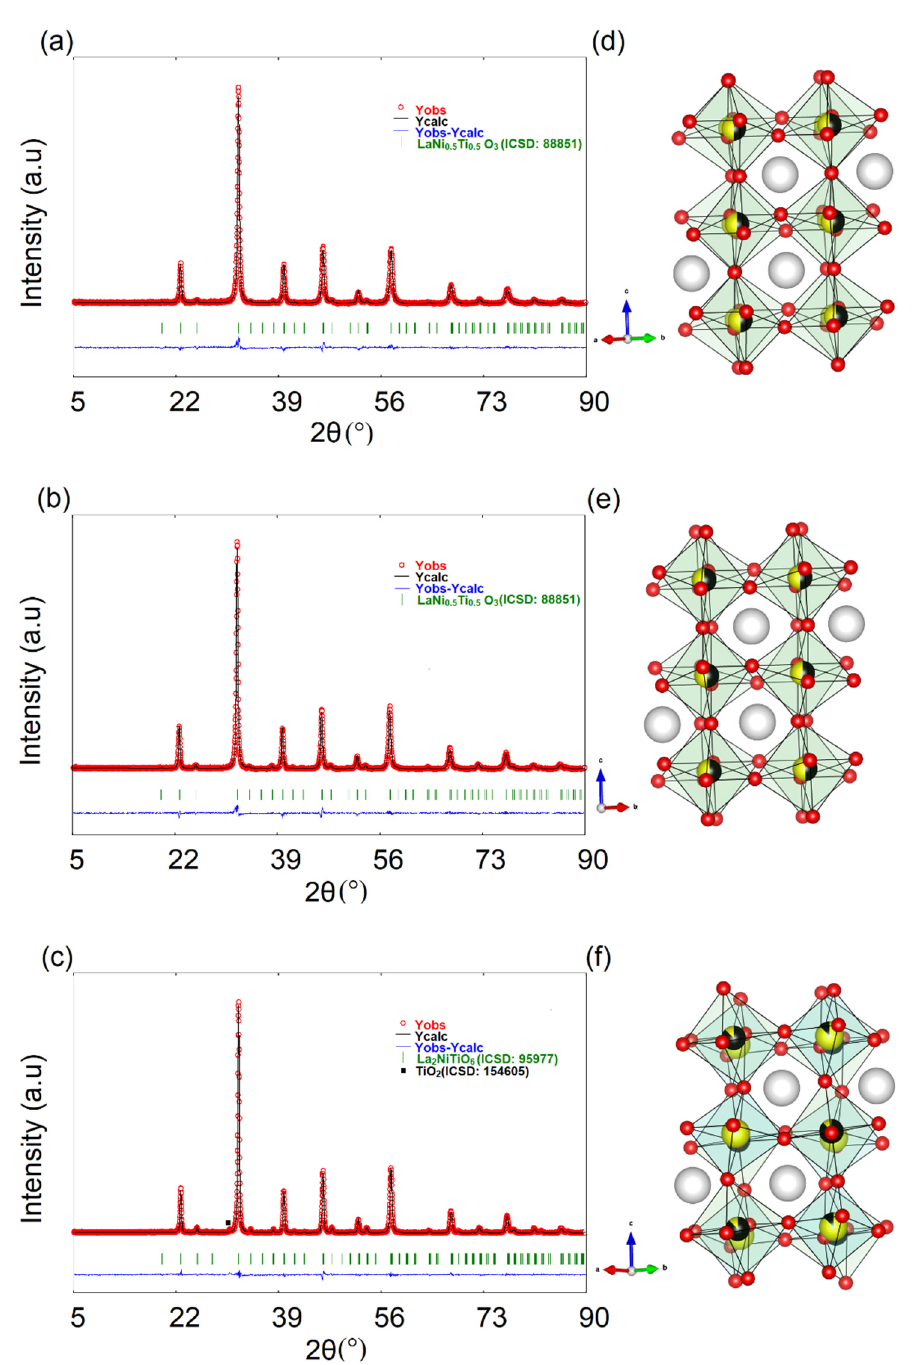
Figure 1. Observed (red symbols), calculated (black line) and difference (blue line) X-ray diffraction profiles of ( a ) Sample 1, ( b ) Sample 2 and ( c ) Sample 3. Crystal structure of ( d ) Sample 1, ( e ) Sample 2, and ( f ) Sample 3. (White, black, yellow, and red spheres denote La, Ni, Ti, and O atoms, respectively).